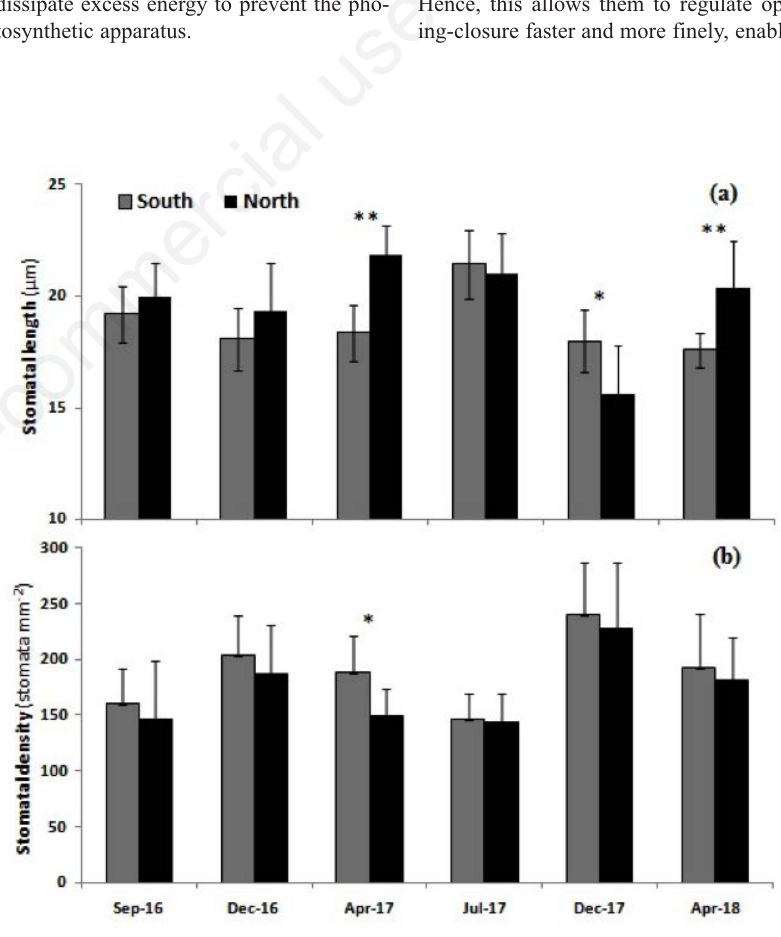
Figure 4. Stomatal length (a) and stomatal density (b) in randomly selected leaves of A. spinosa in the North and the South over the 2016-2017-2018 annual cycles. Values rep- resent mean ± SE, n=30. Asterisks indicate significance levels for the comparison between the two sites within each season by student’s t -tests